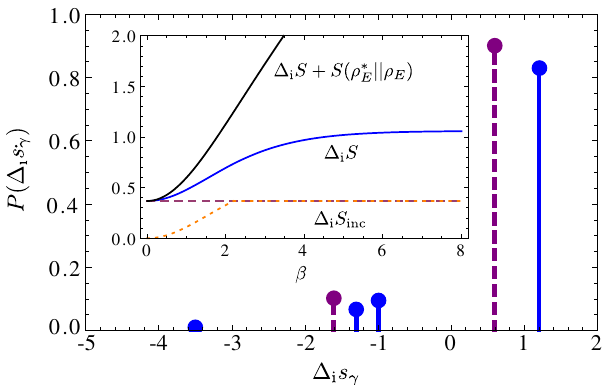
s γ Þ of the entropy pro- FIG. 3. Probability distribution P ð Δ i duction per trajectory for noninclusive (blue solid line) and inclusive (purple dashed line) cases. Initial states of the system and environment correspond to parameters α ¼ 0 . 8 and βϵ ¼ 2 . 5 . Inset: Plot of the different versions of the average entropy production as a function of β ( ϵ ¼ 1 and α ¼ 0 . 8